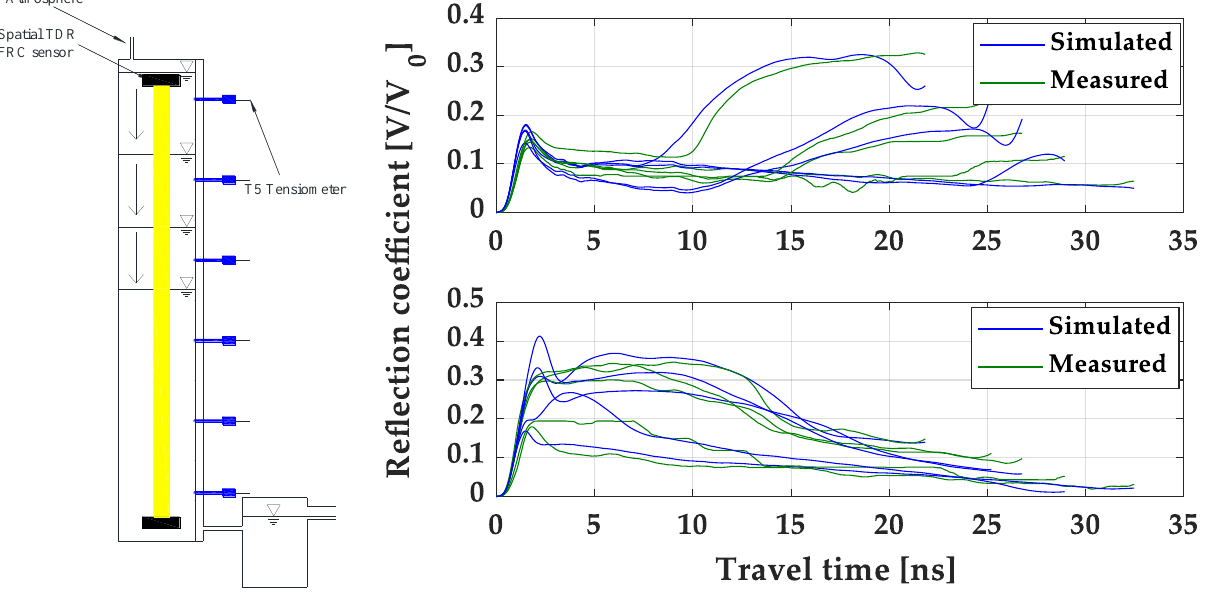
Figure 16. A demonstration of TDR waveforms reconstruction using the fast TDR inversion analysis: the top subplot shows the two-way TDR tracing from the sensor bottom end, and the bottom subplot shows the two-way TDR tracing from the sensor top end with an illustration of the one-step outflow in the soil column filled with Sebilco (30/60) medium sand provided by Sebilco, Australia.